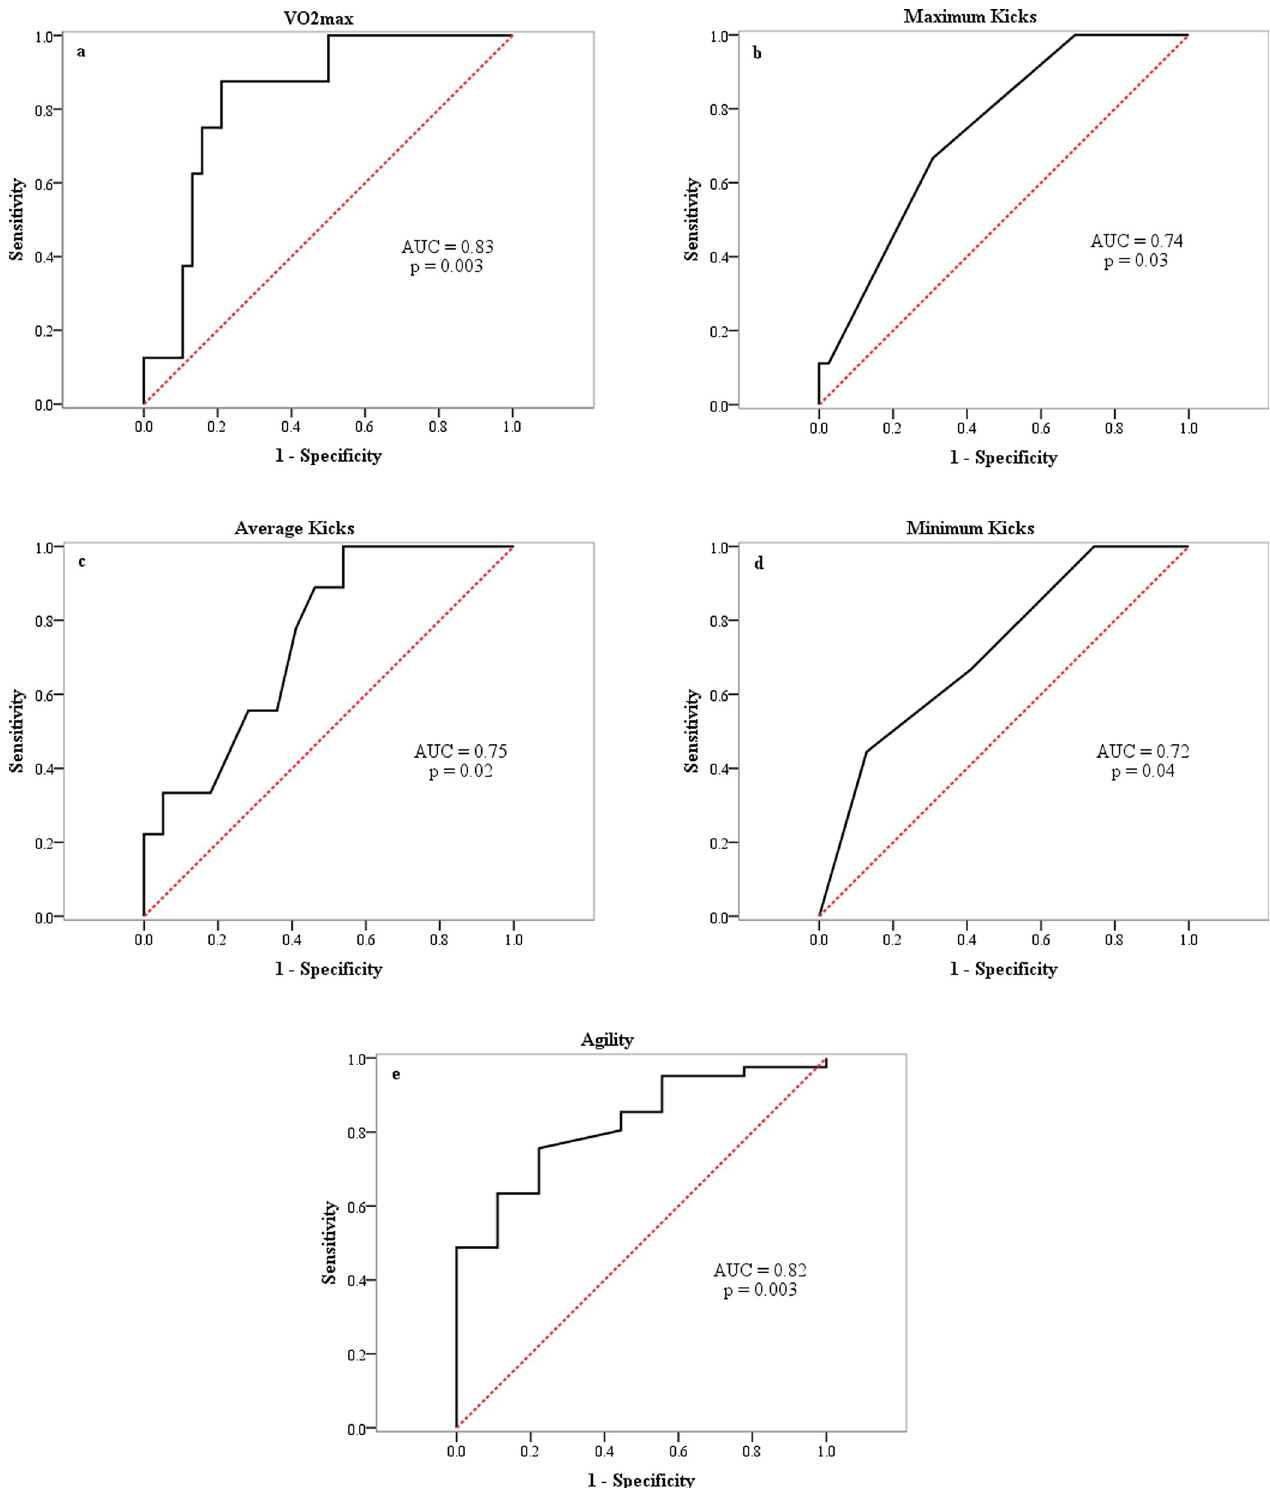
Fig 5. Receiver operating characteristics (ROC) curves for a) the predicted values of aerobic power, b) maximum kicks, c) average kicks, d) minimum kicks, and e) agility records between national- and regional-level taekwondo athletes, using the output of the taekwondo-specific aerobic-anaerobic-agility test. AUC: Area under the ROC